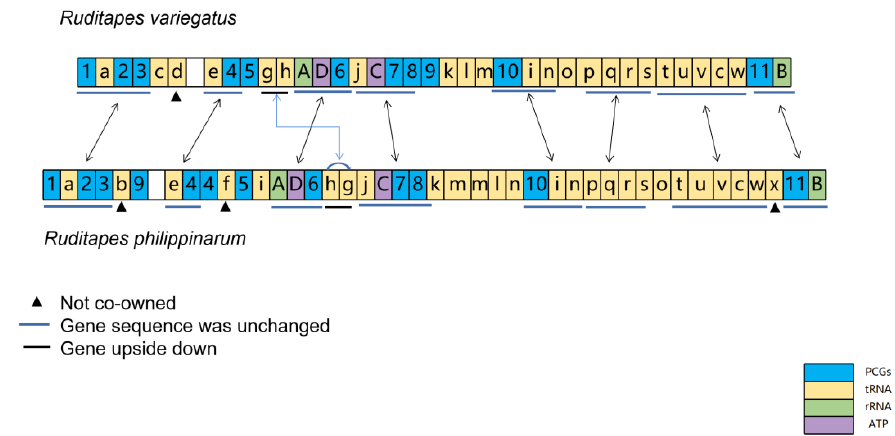
Figure 6. Comparison of mitochondrial DNA gene sequences between Ruditapes philippinarum and R. variegatus . The lowercase letters a–x respectively denote: trnL-TAG, trnY-ATA, trnC-GCA, trnP-AGG, trnI-GAT, trnP-TGG, trnE-TTC, trnH-GTG, trnN-TTT, trnS-TGA, trnY-GTA, trnD-GTC, trnM-CAT, trnV-TAC, trnG-TCC, trnF-GAA, trnW-TCA, trnR-TCG, trnL-TAA, trnQ-TTG, trnN-GTT, trnT-TGT, trnA-TGC, and trnS-TCT; the numbers 1–11 respectively denote COX1, ND1, ND2, COX2, CYTB, ND4, ND3, ND5, ND4L, ND6, and COX3; capital letters A–D indicate rrnL, ATP8, ATP6, and rrnS, respectively.